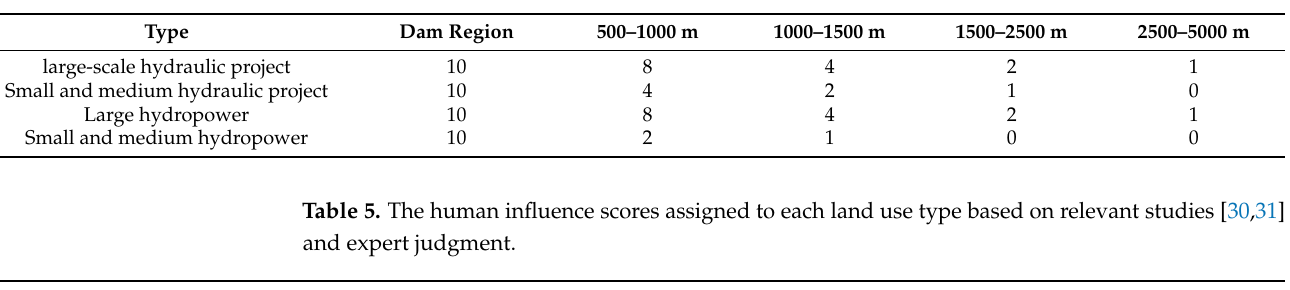
Table 4. Parameter table of influence degree and scope of hydropower and water reservoirs facilities.